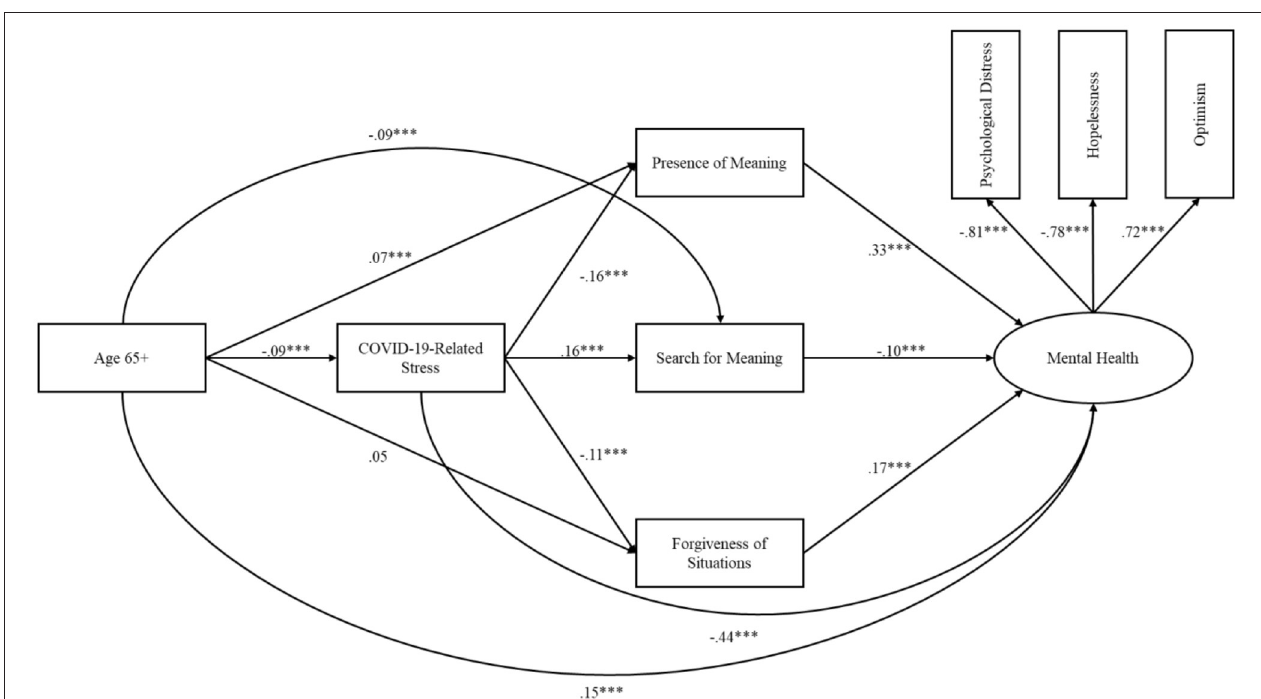
FIGURE 2 | Results of structural equation model showing associations between older age, COVID-19-related stress perceptions, meaning, forgiveness, and mental health. Structural equation model of direct and indirect associations of older age with COVID-19-related stress perceptions, presence of and search for meaning, forgiveness of situations, and mental health. All coefficients are standardized and adjusted for sex, race, education, and income. *** p < 0.001.